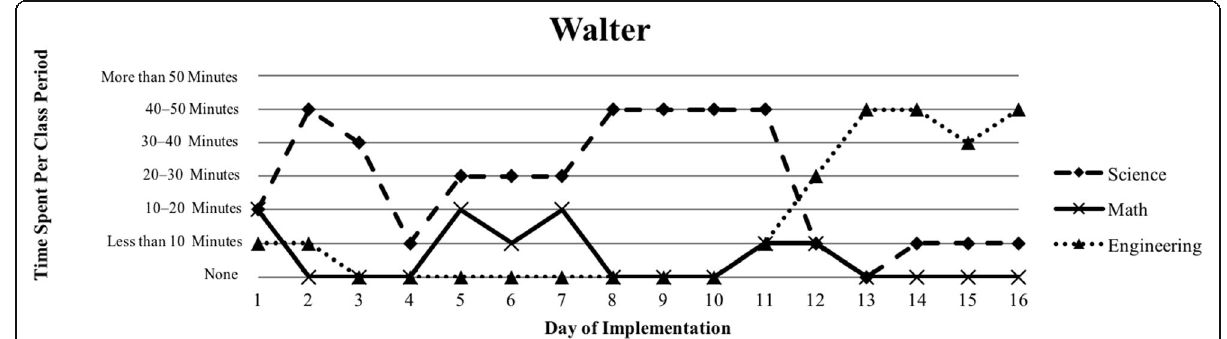
Fig. 5 Walter ’ s implementation of the Heat Transfer 2 in his 6th grade science